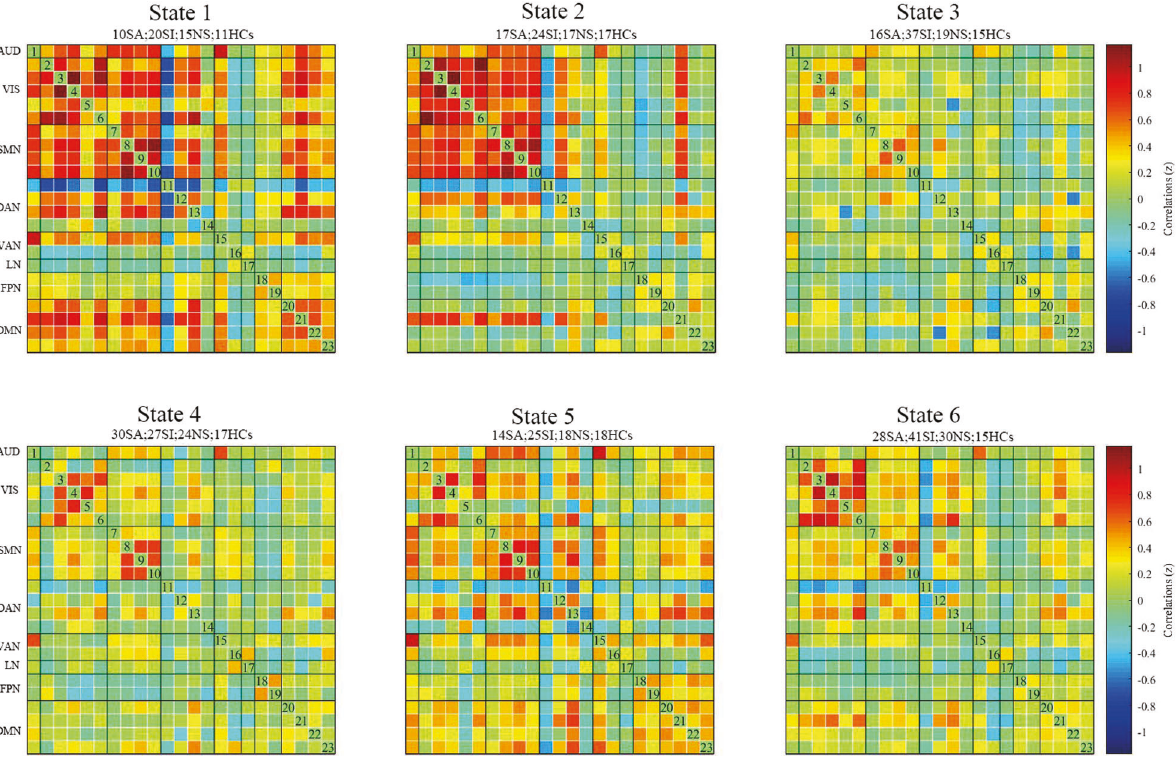
Fig. 2 State plots and the number of members in each group with each state. Whole-brain cross-correlation matrices of states 1 – 6 are shown. The number of participants who entered each state is indicated above the state plots. SA suicide attempter, SI suicide ideation, NS neither SA nor SI, HCs healthy controls, AUD auditory network, VIS visual network, SMN somatomotor network, DAN dorsal attention network, VAN ventral attention network, LN limbic network, FPN frontoparietal network, DMN default mode